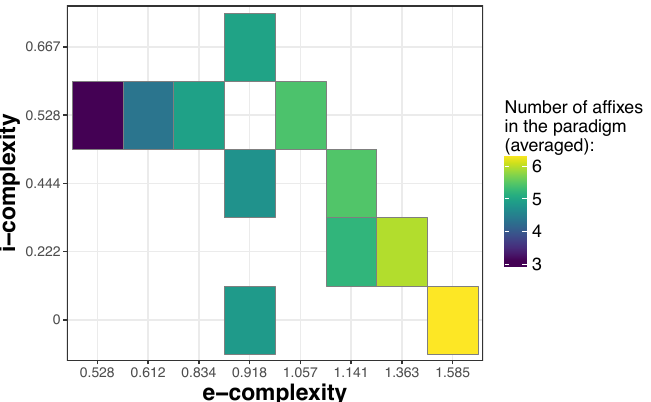
Figure 8: Distribution of randomly generated paradigms in terms of i- and e-complexity. Colour represents the average number of markers for paradigms with specific i- and e-complexity values. No paradigms have high i-complexity and high e-complexity. Paradigms with high i-complexity and low e-complexity have on average fewer markers while paradigms with low i-complexity and high e-complexity have